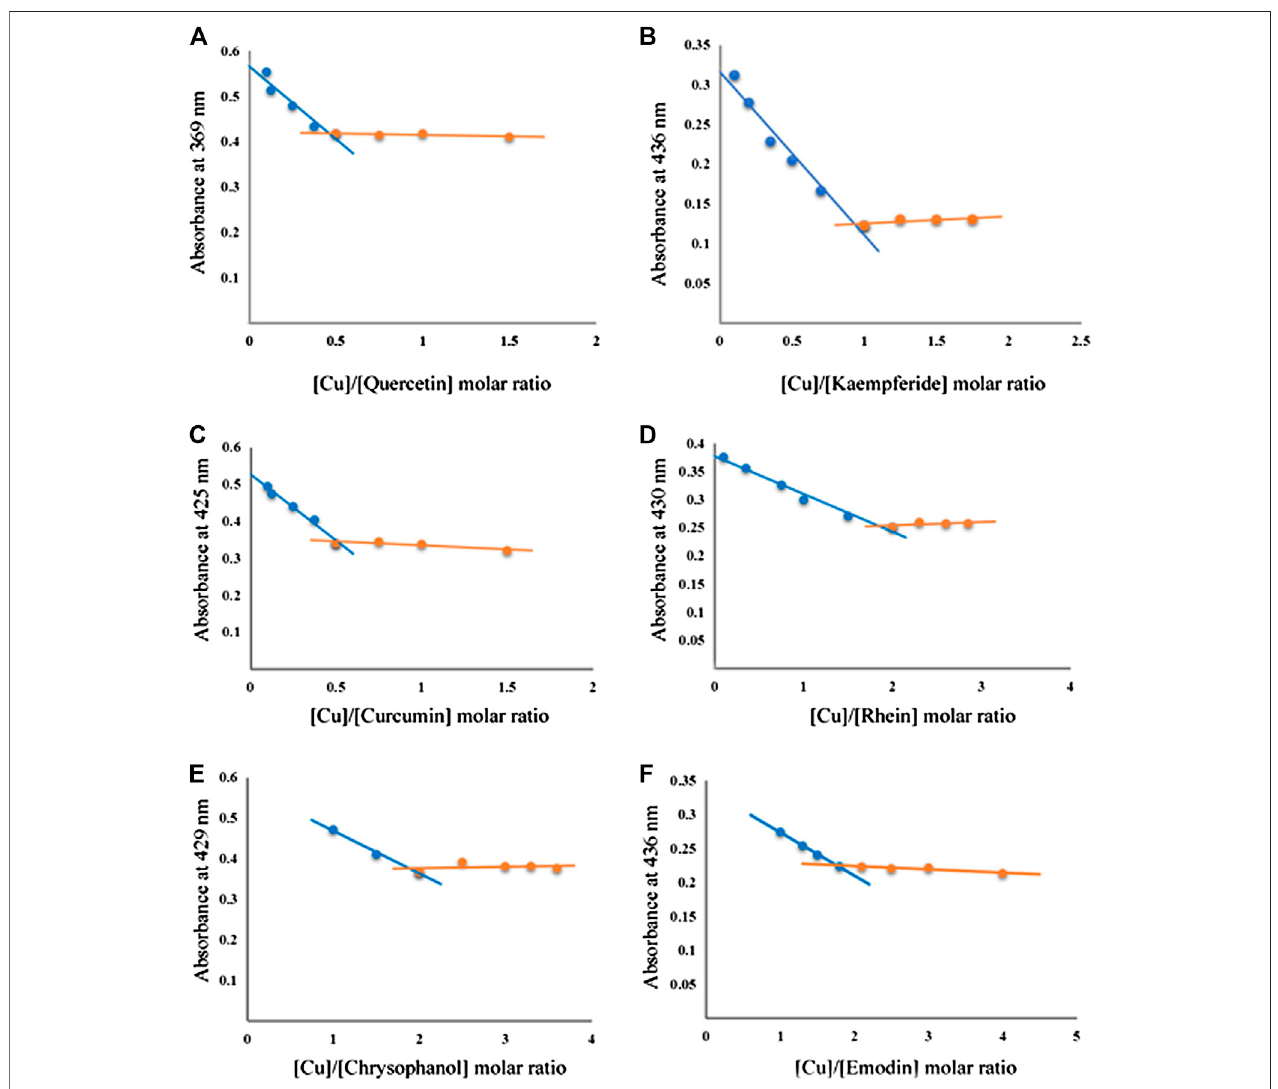
FIGURE 6 | The plot of the absorbance at λ max vs. mole fraction of compounds. (A) quercetin; (B) kaempferide; (C) curcumin; (D) rhein; (E) chrysophanol; (F) emodin.